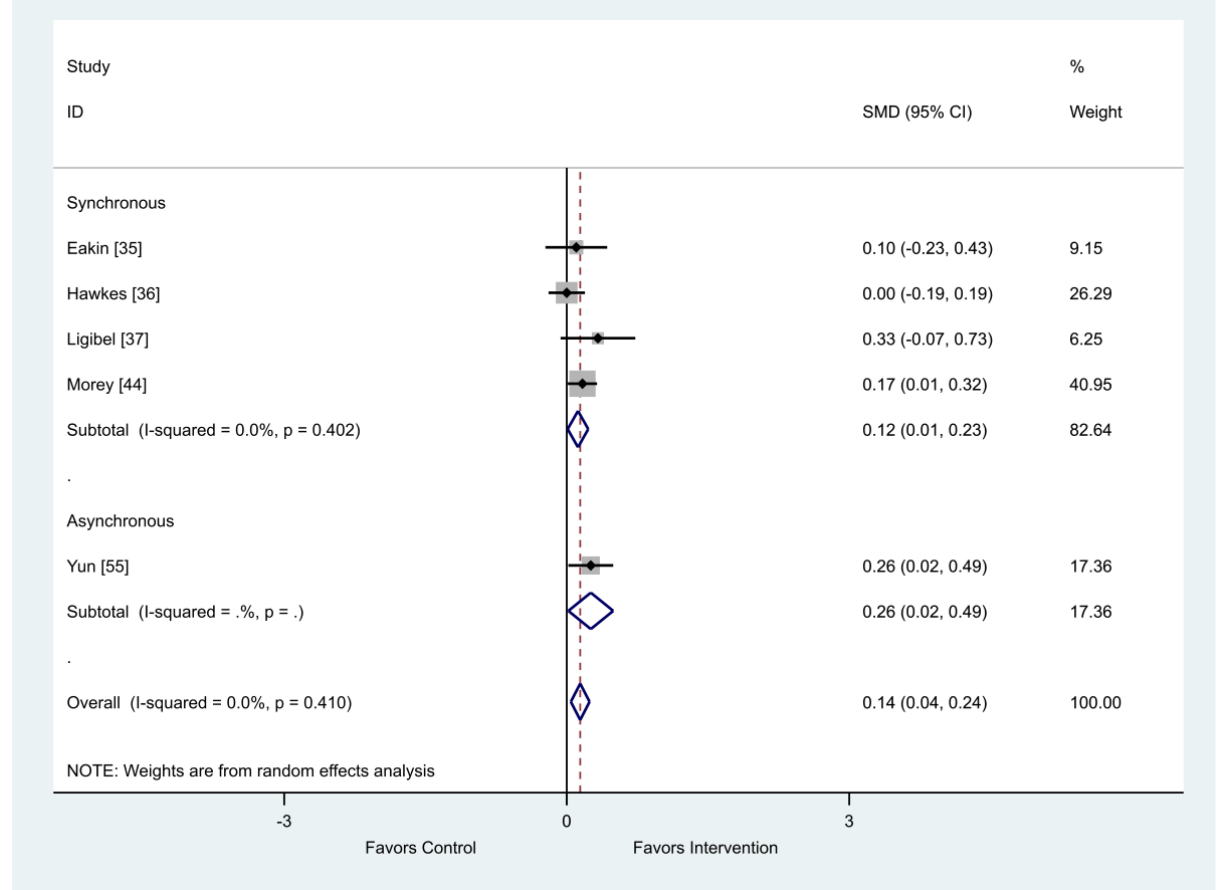
Figure 7. Effect of electronic health interventions with a control on quality of life interventions, analyzed using standardized mean difference (postintervention mean and SD change scores). SMD: standardized mean difference.